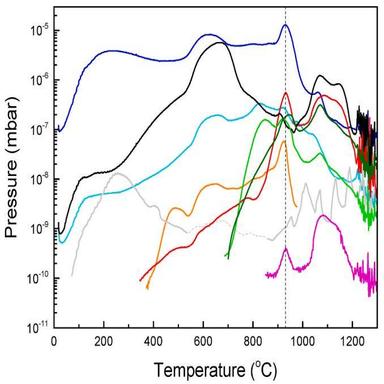
RGA traces for H2 (cyan), NO (grey), CO2 (black), H2S (orange), SO2 (red), SO3 (magenta), HF (dark green), and HCl (light green) as a function of temperature. For approximate quantitative comparison purposes, the respective main RGA peaks) were scaled to account for the full amount of the compound (see text), and are shown only in the ranges where they were conclusively identified. (For interpretation of the references to color in this figure legend, the reader is referred to the Web version of